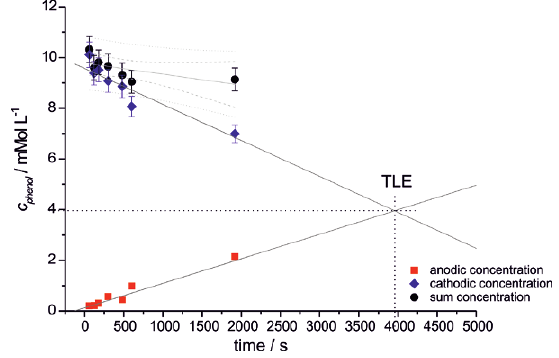
Figure 8. Exp. 2b: Transport of phenol from cathode to anode beaker. The grey dashed line marks the theoretical mixture concentration (5 mmol L -1 ); the black dashed lines show concentration and time at the theoretical linear equilibrium (TLE). The concentration sum is evaluated with a linear fit including 95% confidence (dashed) and 95% prediction (dotted) intervals.